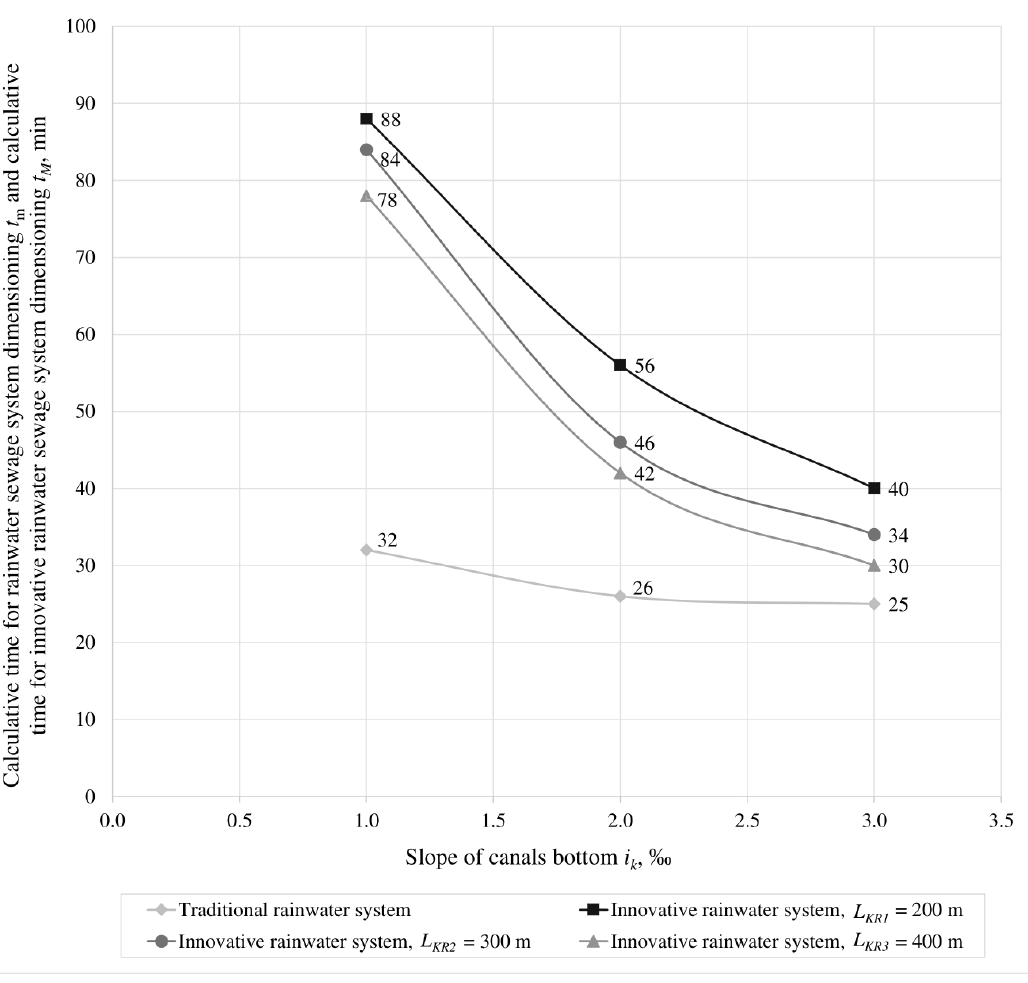
and calculative time for innovative rainwater sewage system m